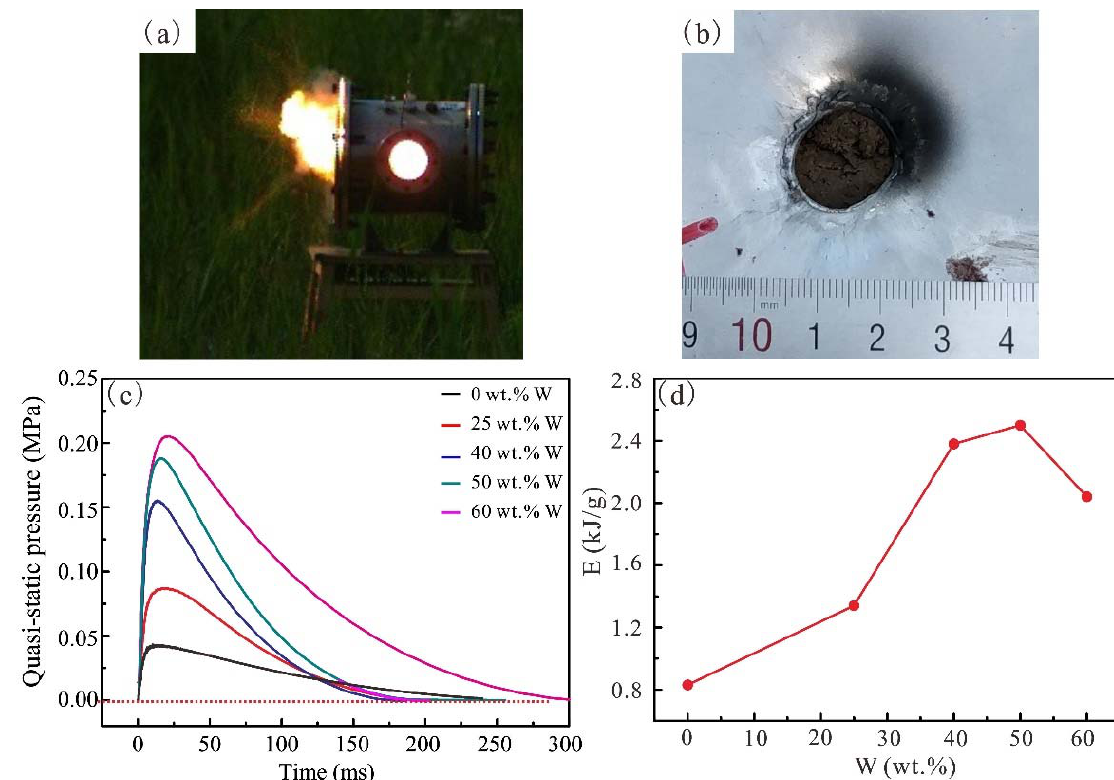
Figure 6. Energy release behaviors under high-speed impact loading. ( a ) The flame captured by a high-speed camera; ( b ) bullet hole; ( c ) quasi-static pressure inside test chamber; ( d ) relationship between released energy and the W content.